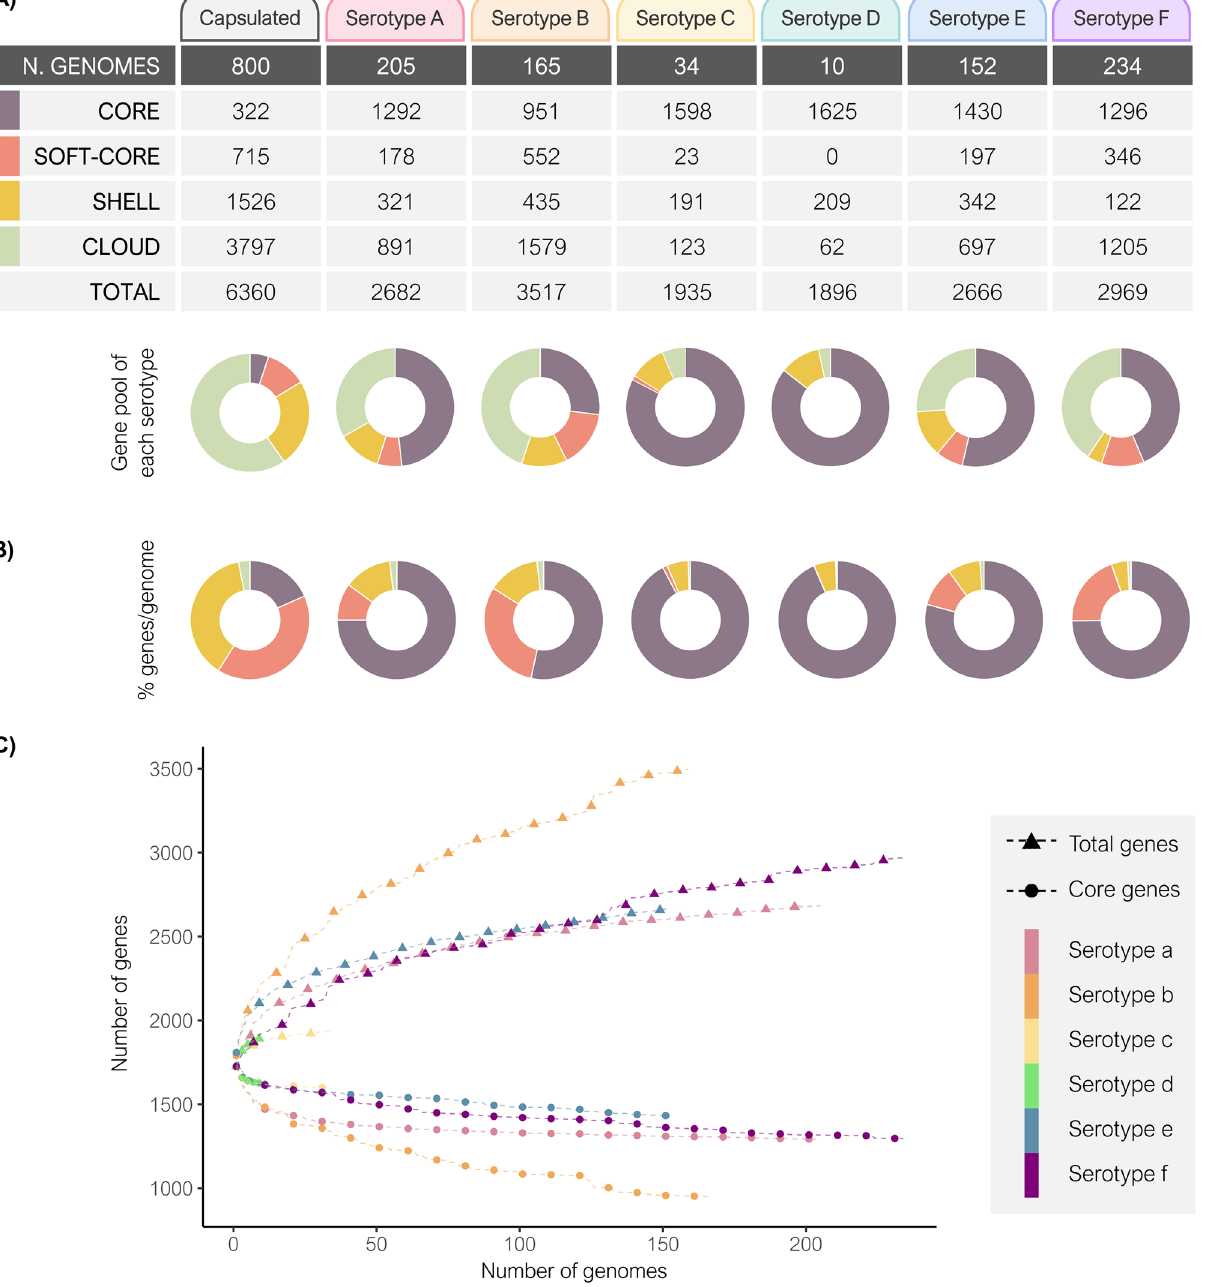
Differences in the gene pools were observed when serotypes were analysed separately (Fig. 2A). H. influenzae serotype b showed the largest gene pool (n = 3517) compared to the other serotypes, which oscillated between 1896 and 2969 genes. Moreover, serotype b had the lowest core genome proportion (42.7%) due to the large amount of cloud genes detected in the gene pool (44.9%). By contrast, serotypes c and d had a small gene pool